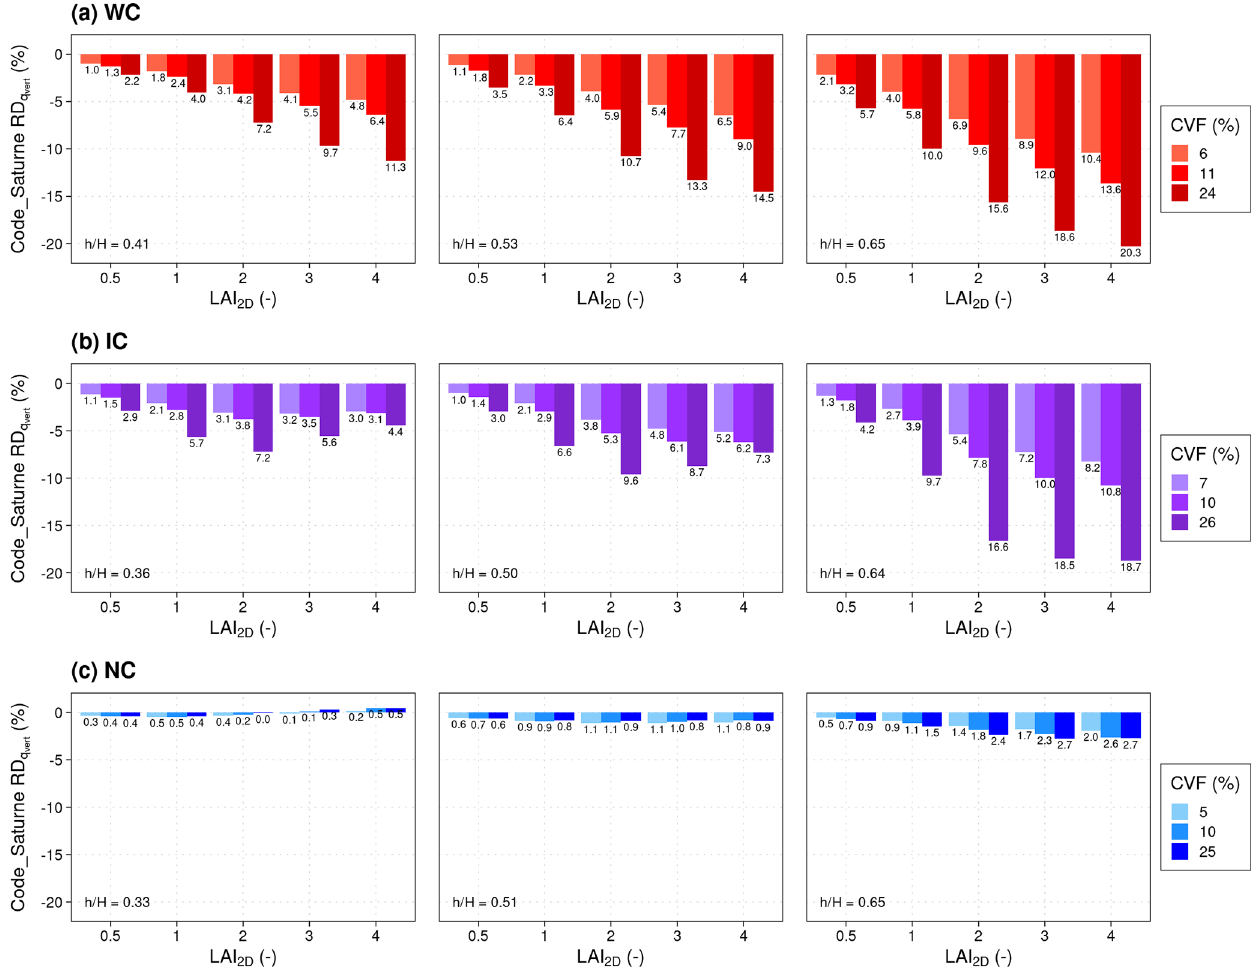
Figure 3. Relative deviation (RD) of q vert computed from Code_Saturne simulations for different tree LAI 2D , CVF, and height ratio for WC (a) , IC (b) , and NC (c) . The graphic is divided into three columns corresponding to the three height ratios, and higher CVF correspond | values are specified with data to darker colors. | RD q vert